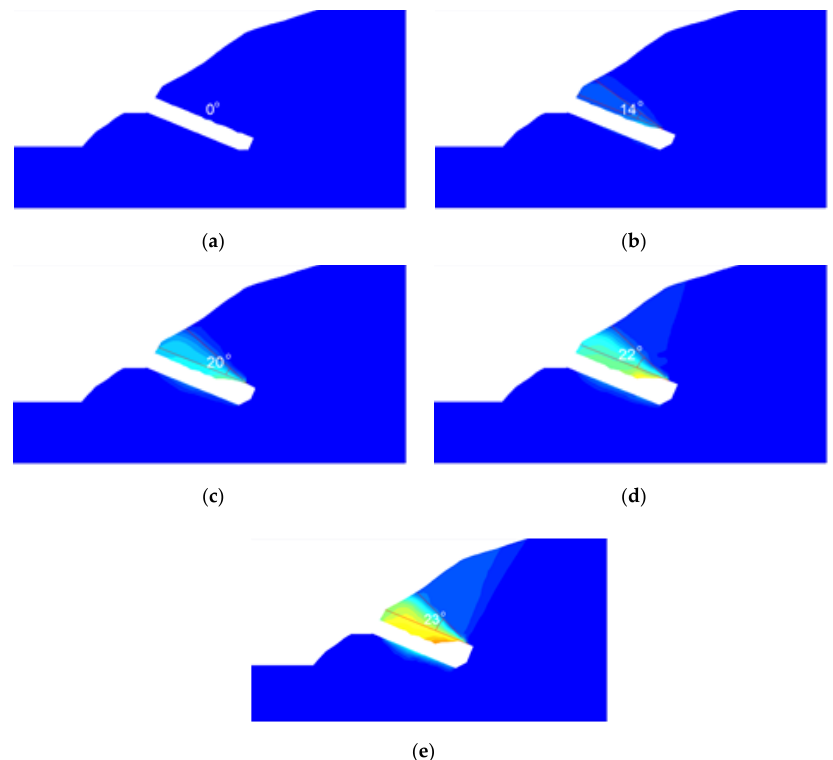
Figure 7. Surrounding soil failure mode and angle based on the enlarged height of the tunnel-type anchorage: ( a ) H = 0 m, ( b ) H = 2 m, ( c ) H = 4 m, ( d ) H = 6 m, and ( e ) H = 8 m.